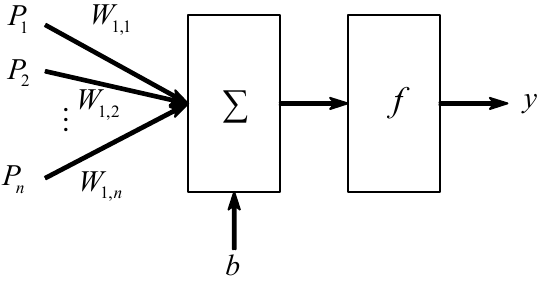
Figure 5. Model of back propagation (BP) neurons.